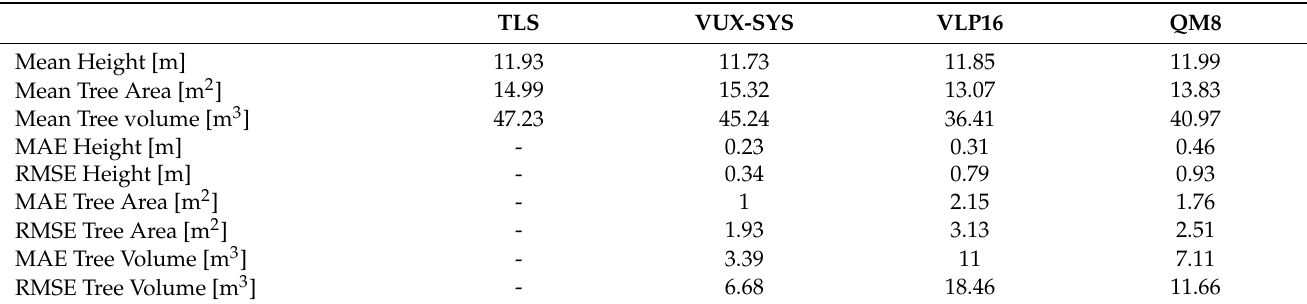
Table 3. Mean values for individual tree parameters calculated for all trees in the plot, and the mean absolute errors and root-mean-squared error for individual tree parameters, using TLS data as